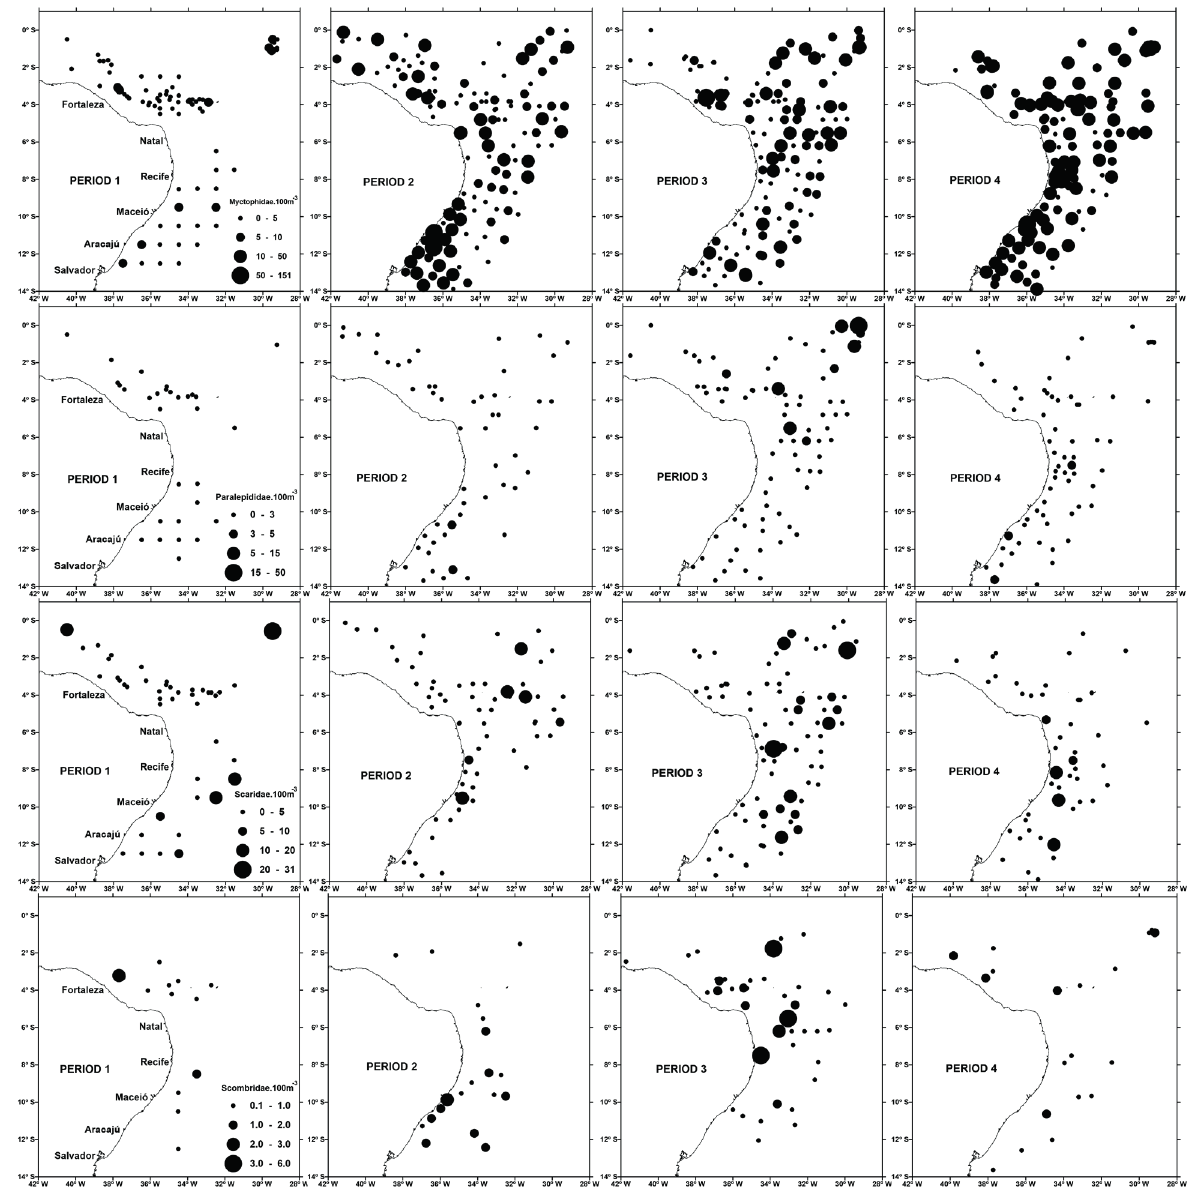
Figure 6 - Distribution and density (larvae.100m -3 ) of the fish larvae families (Myctophidae, Paralepididae, Scaridae and Scombridae) in the west tropical Atlantic